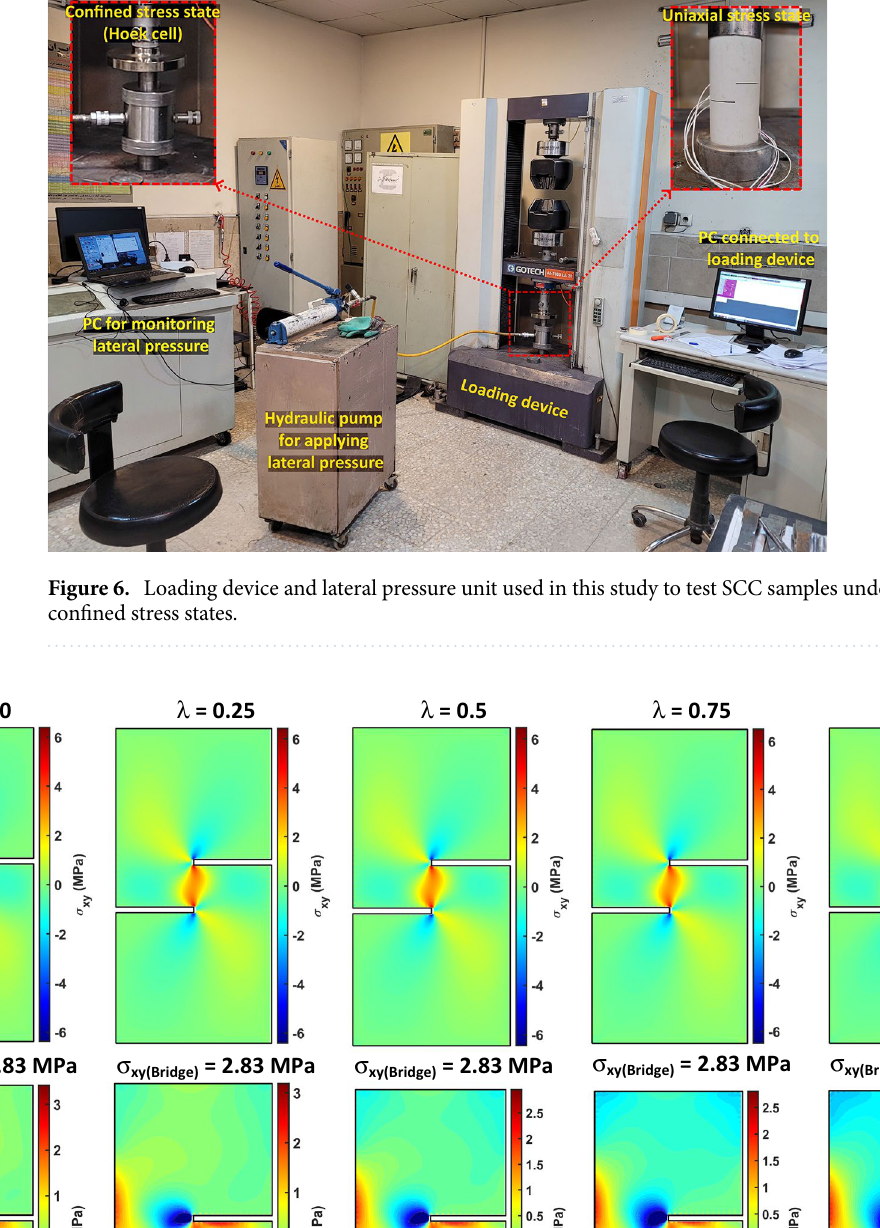
Figure 7. Shear stress σ xy and maximum principal stress σ max as a function of stress ratio λ = σ H /σ V in SCC specimens for (H = 100 mm, D = 50, C = 15, a =